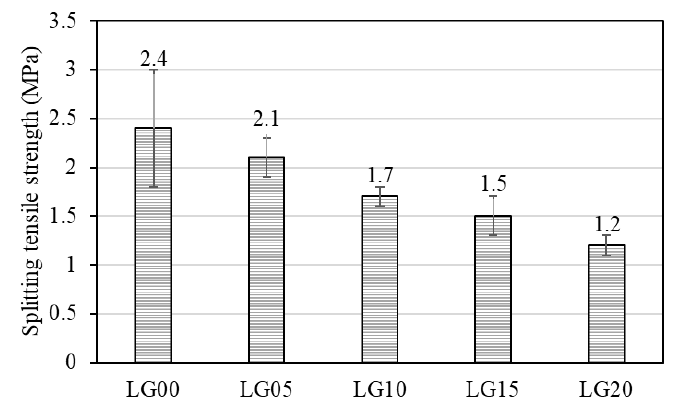
Figure 8. Flexural strength of geopolymer mortar containing BLWA.